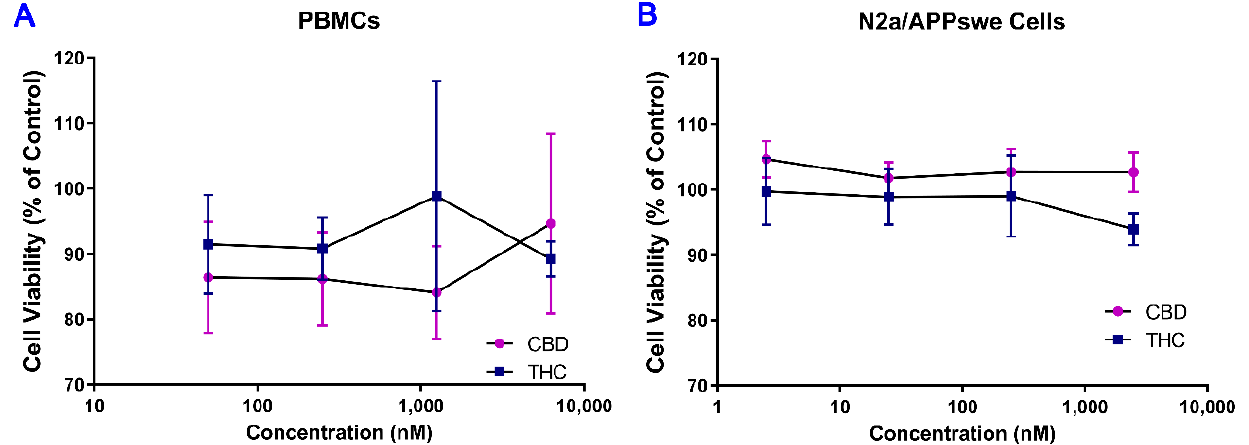
Figure 1. Determination of cytotoxicity of THC and CBD in ( A ) PBMCs and ( B ) N2a/APPswe cells. Concentration-effect curves demonstrated that treatment with THC or CBD for 40 h had no significant effect on the viability of cultured PBMCs and N2a/APPswe cells over a concentration range of 0.0625–6.25 μ M and 0.0025–2.5 μ M, respectively. Data are expressed as mean ± standard deviation (SD) ( N = 3 for PBMCs. N = 5 for N2a/APPswe cells). Error bars denote SD.